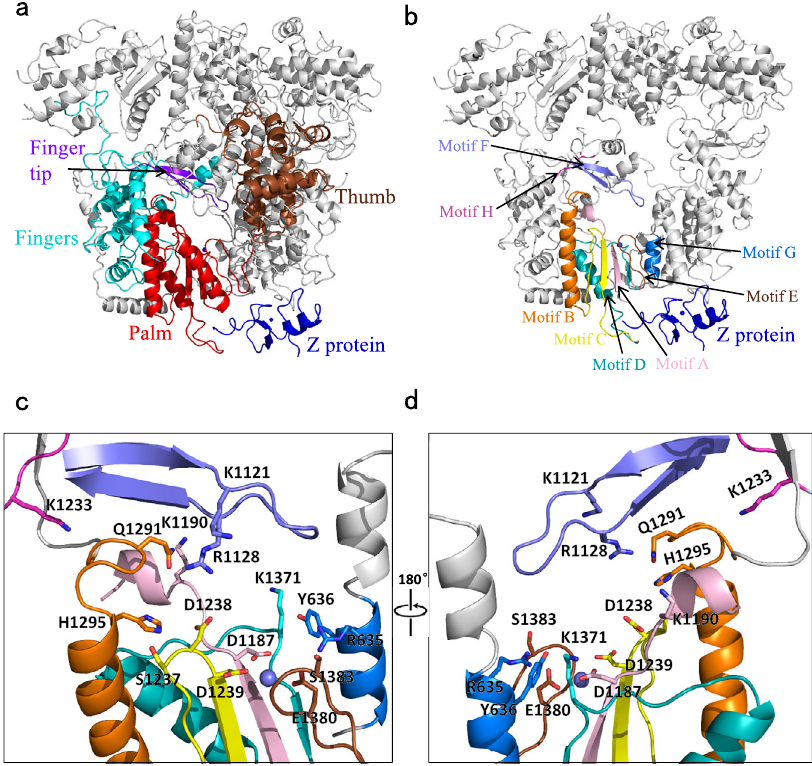
Fig. 3 Structure of the JUNV L RdRp region. a The RdRp region is highlighted in colors: the fi nger is shown in cyan, the thumb in brown, the palm in red and the fi nger tip in purple. The Z protein is colored in blue and the remaining structure of L is colored in gray. b Similar view as shown in ( a ), but motifs A – H are highlighted in unique colors. The Mg atom is shown as a purple sphere, and the Zn atom is shown as blue sphere. c , d Magni fi ed views of the active site, colored as in ( b ). Residues selected are shown as sticks, with oxygen atoms shown in red, nitrogen atoms shown in blue. The Mg atom is shown as a purple sphere. d Region identical to that in ( c ), but rotated by 180° along the vertical